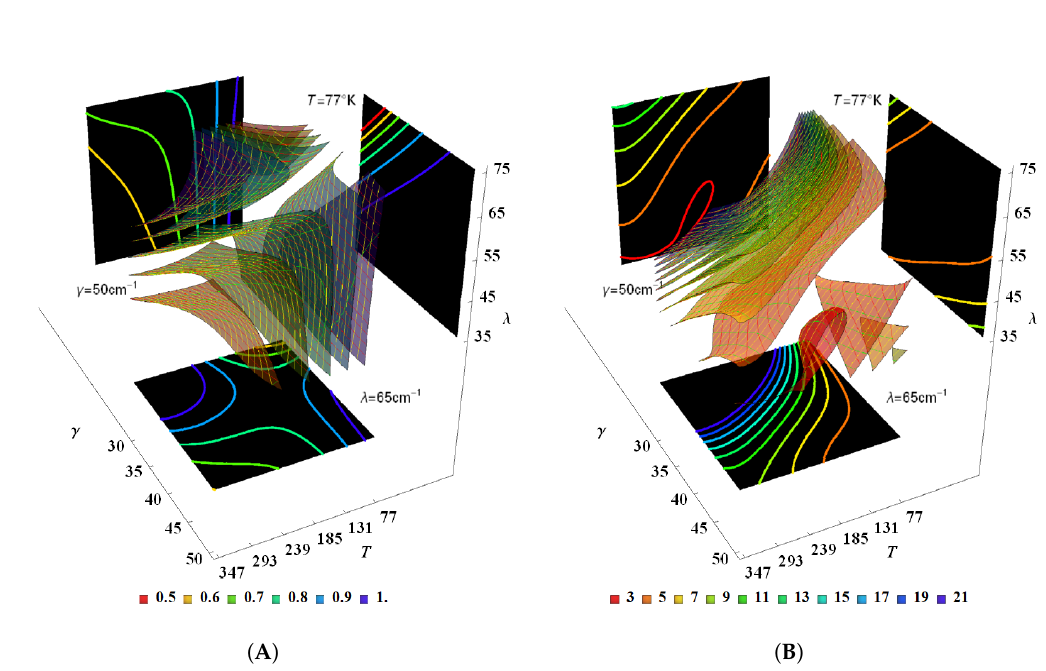
Figure 13. ( A ) Eficiency η in the entire dynamic, and ( B ) transference time T t T , λ k and γ k